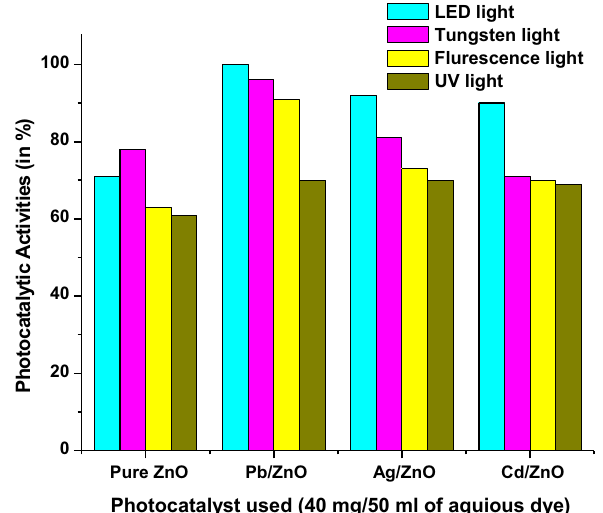
Fig. 9 Photocatalytic activities of modified ZnO nanoparticles under different light